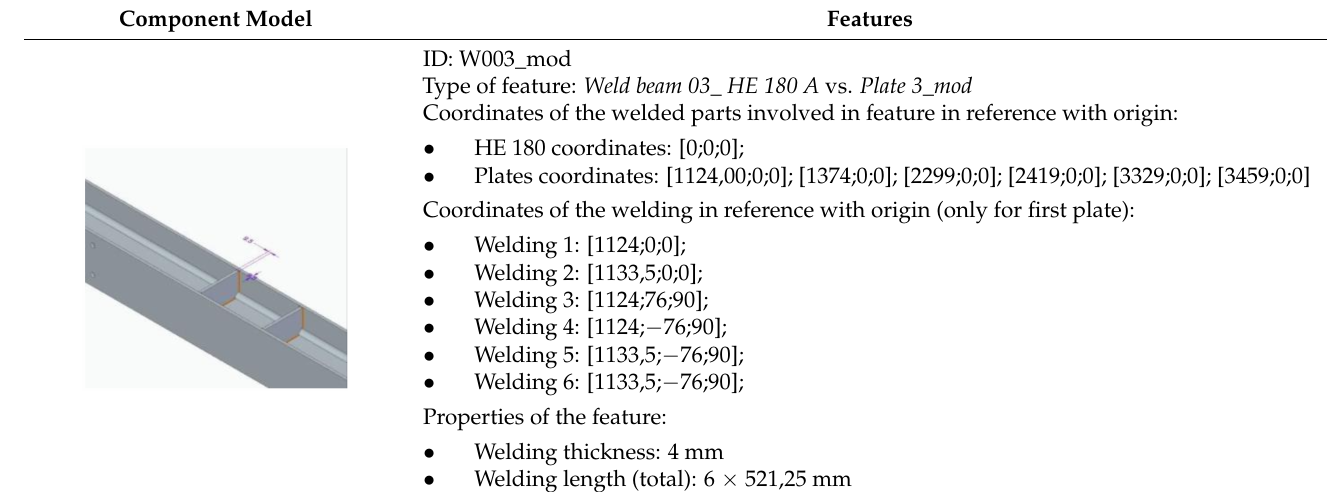
Table 7. Modified welding features (highlighted in orange) extracted by the 3D CAD model of the lateral frame. Component